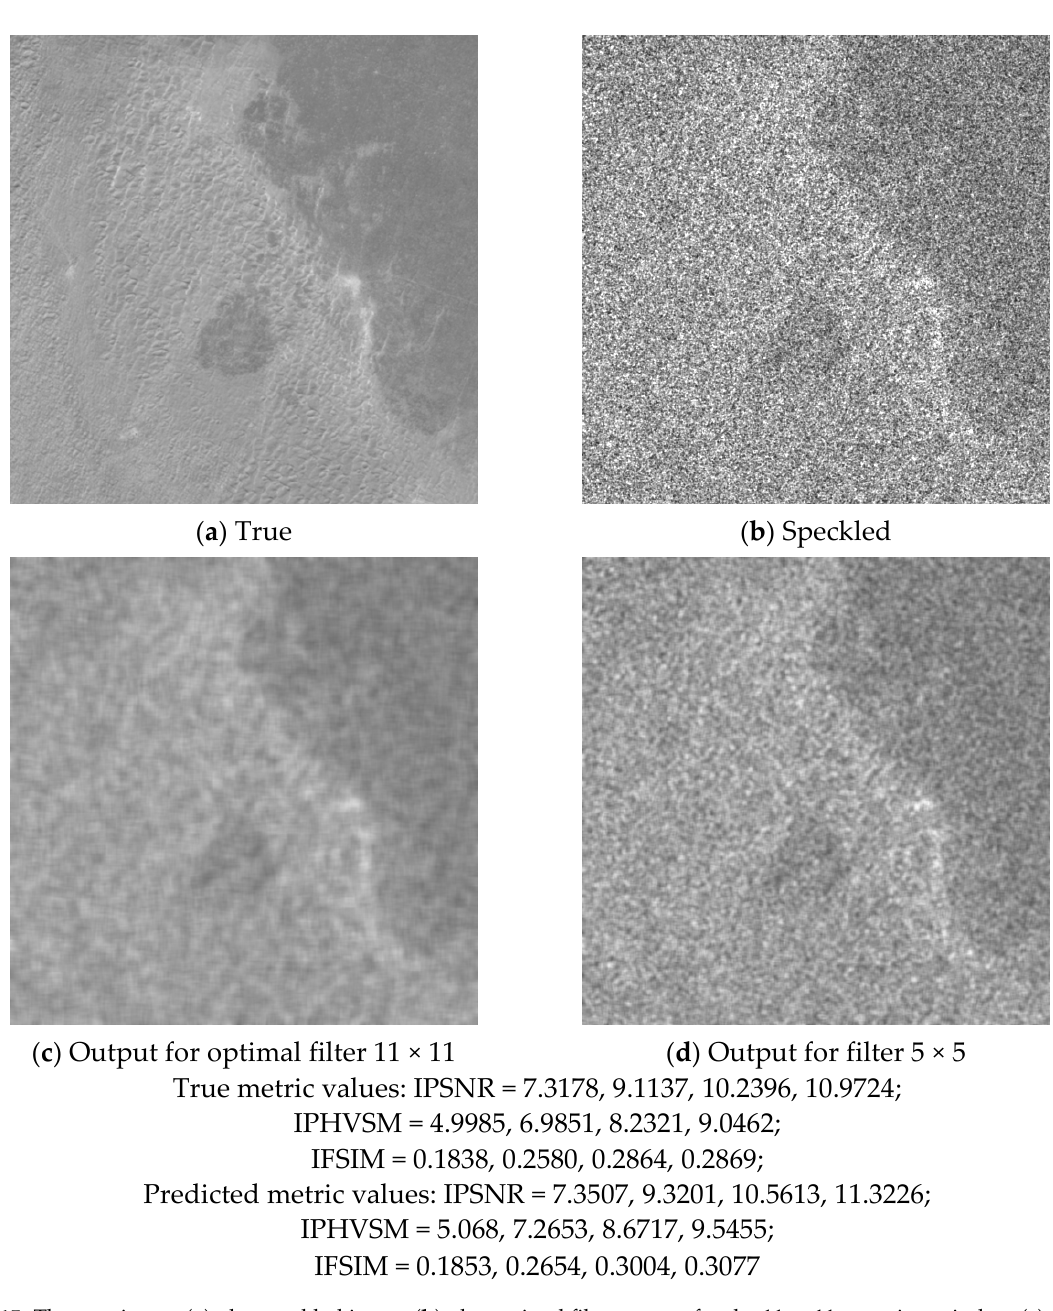
Figure 15. The true image ( a ); the speckled image ( b ); the optimal filter output for the 11 × 11 scanning window ( c ); and the filter output for the 5 × 5 scanning window ( d ).